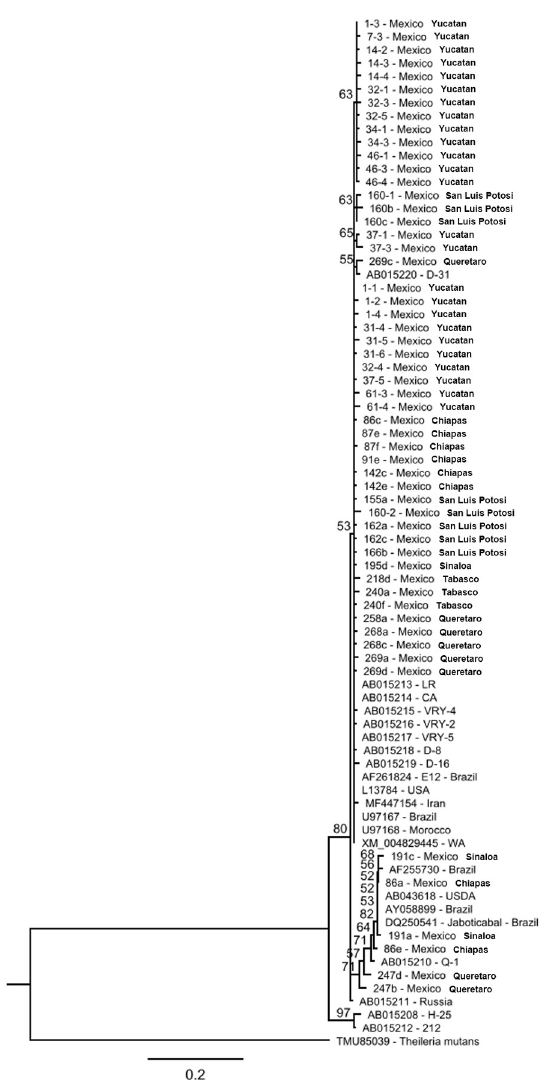
Fig 9. Phylogenetic tree constructed using EMA1 amino acid sequences generated in this study and similar sequences deposited in GenBank (sequence names start with an accession number). Translated TMU85039 sequence of the T . mutans homologue served as an outgroup. Bootstrap support values over 50 are shown on the nodes. Rosales et al . [30], with 23.2% positive samples to antibodies against B . caballi and just 4.4% of DNA positive samples. In the case of T . equi , the proportion of seropositive samples (68.4%) was less than the nPCR-positive samples (78.8%). This could be due to early infections with parasites detectable in blood in the absence of serum antibodies in a proportion of animals, or, in rare cases, could have happened due to the higher severity of the disease caused by T . equi that is described by some authors. Also could involve a minor amount of protective antibodies, lack of memory antibodies production or maybe a state of immune tolerance against this para- site due that has been reported as uncommon to clear from the host [16] and to remain present in circulating blood at detectable levels (despite fluctuating parasitemia levels) throughout the infection stages [21, 38]. Rosales et al . [30] reported 14% positive samples to serology and